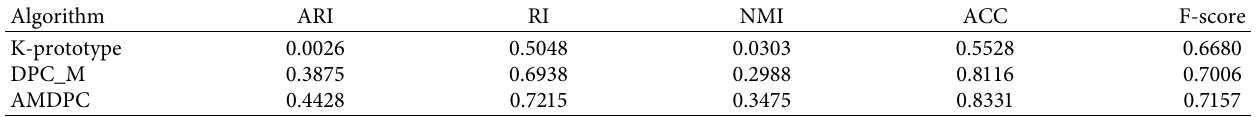
Table 6: Clustering results of Credit dataset.